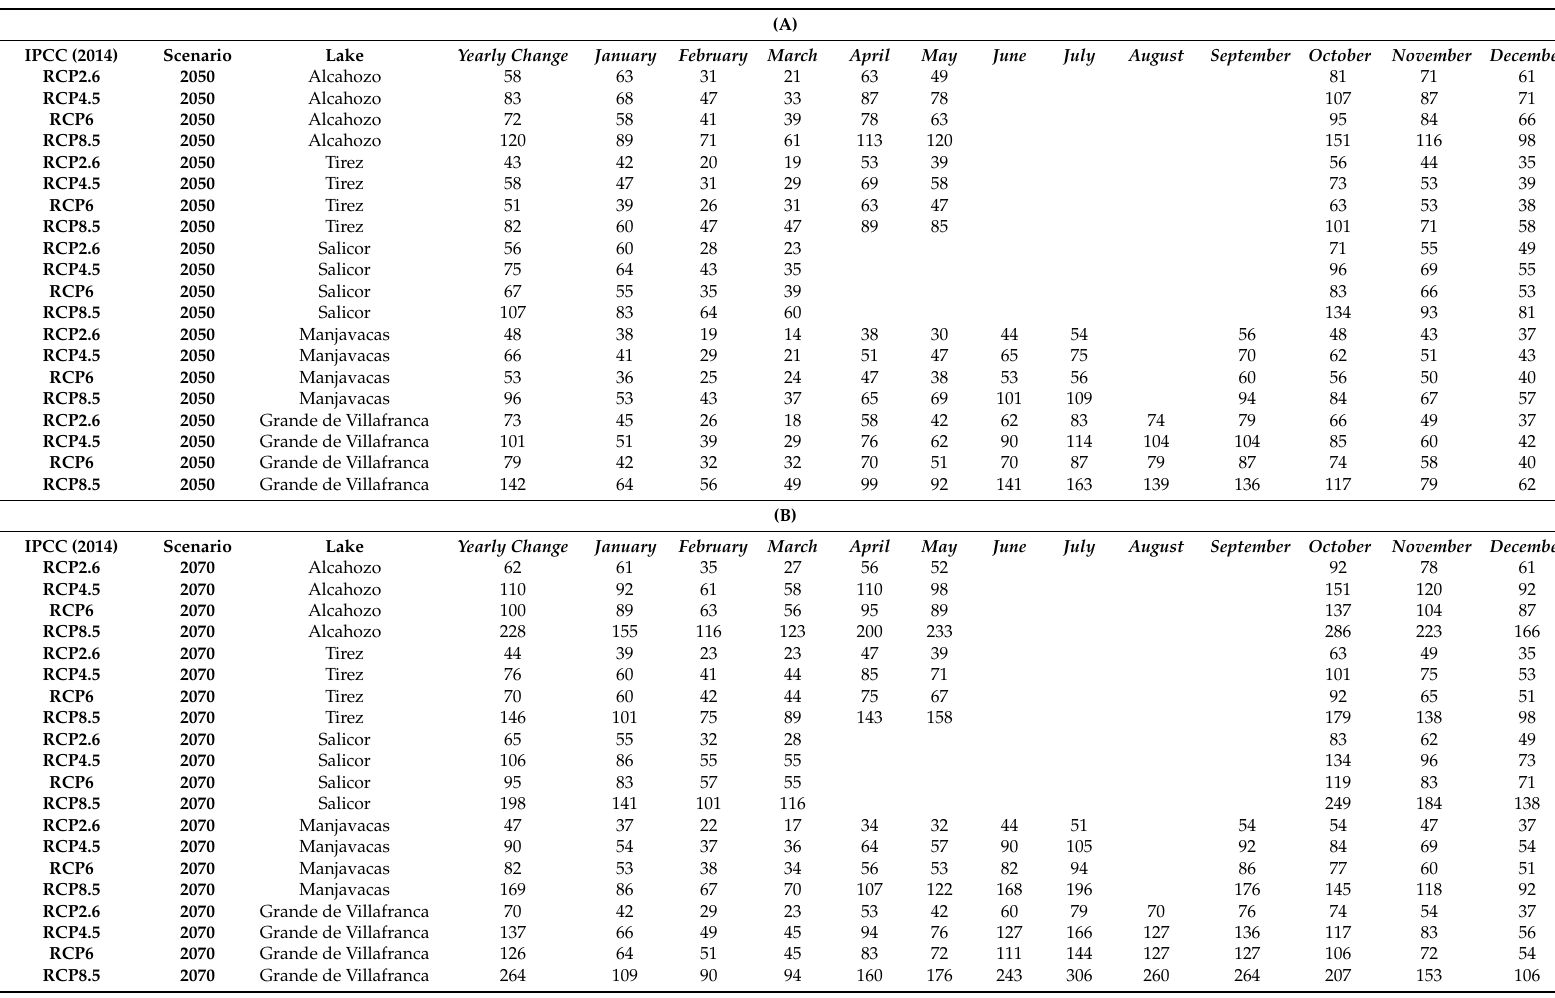
Table 2. Percentage of yearly and monthly increase predicted for methane emissions of the studied lakes determined by the predicted changes of temperature within the different IPCC Scenarios [1]: RCP2.6, RCP4.5, RCP6 and RCP8.5 by ( A ) 2050, and by (B)